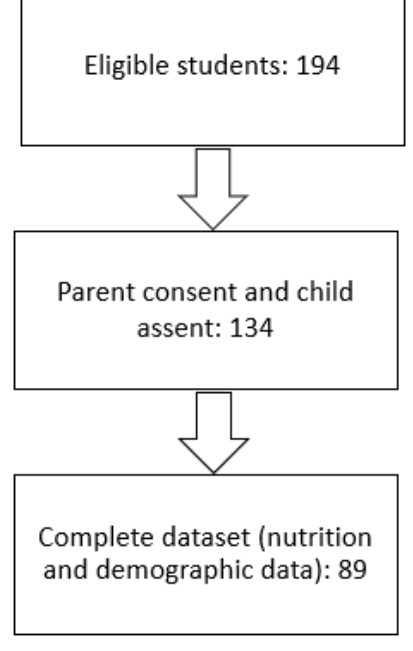
Figure 1. Flow chart from eligibility to final sample size.